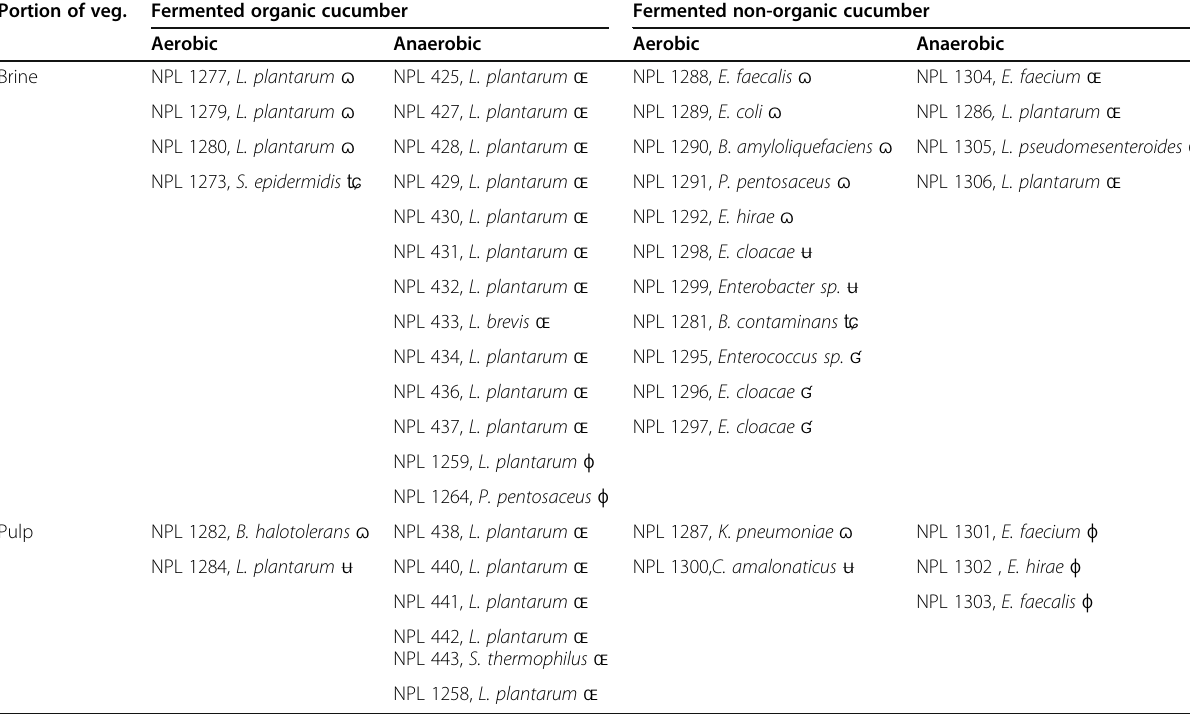
Table 1 Background details of bacterial isolates from fermented cucumber Portion of veg. Fermented organic